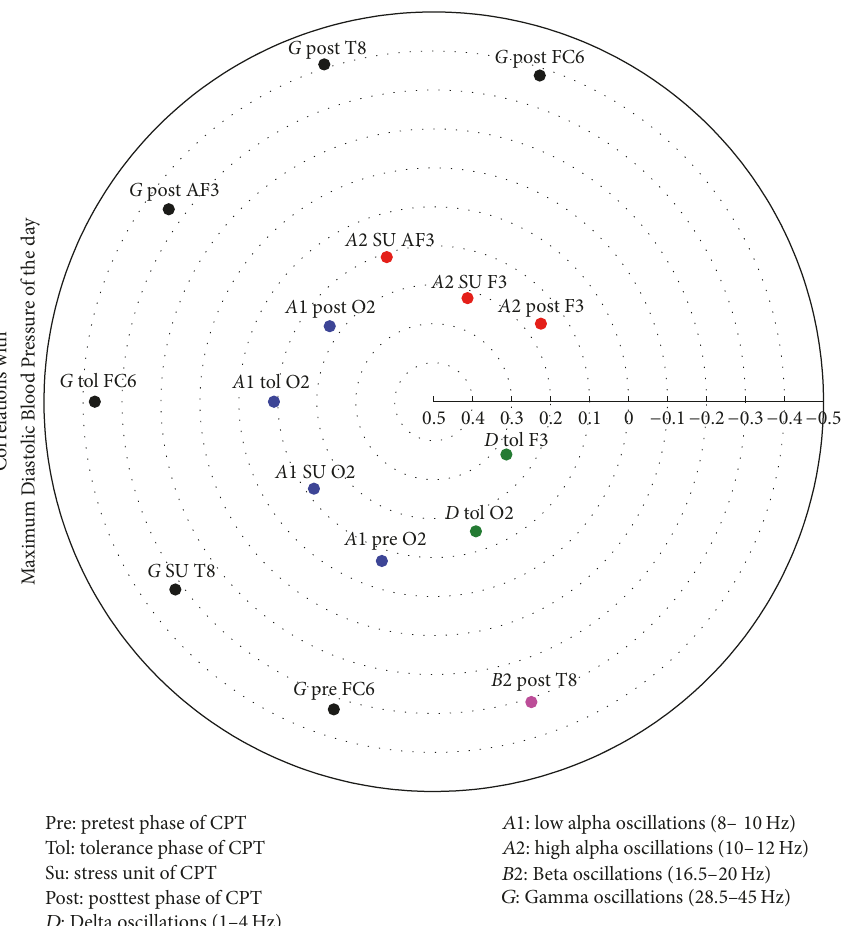
Figure 9: Heliograph of the correlations between Maximum Diastolic Blood Pressure of the day and the statistically significant different CPT-induced EEG oscillations depicted by concentric circles in the ( − 1)-(0)-(+1)